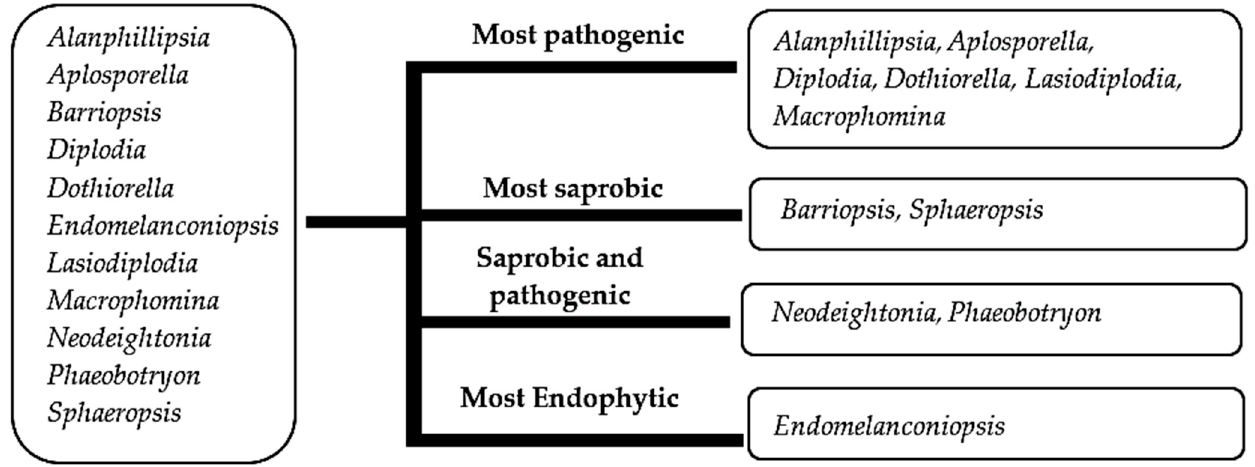
Figure 8. Genera with pigmented conidia and their nutritional modes.